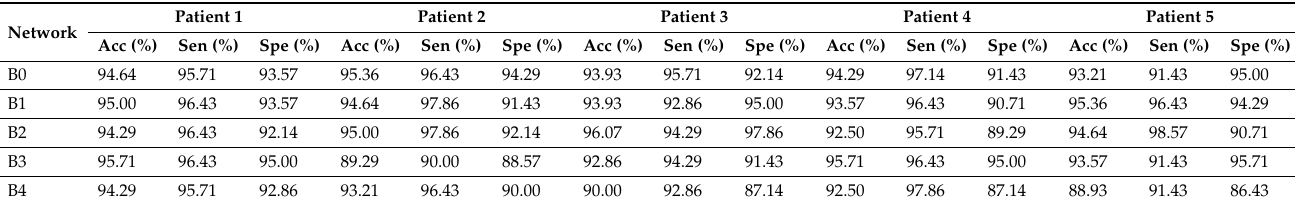
Table 6. The results of Experiment 2 when transfer learning was not used. Acc, Sen and Spe are the abbreviations for accuracy, sensitivity, and specificity,